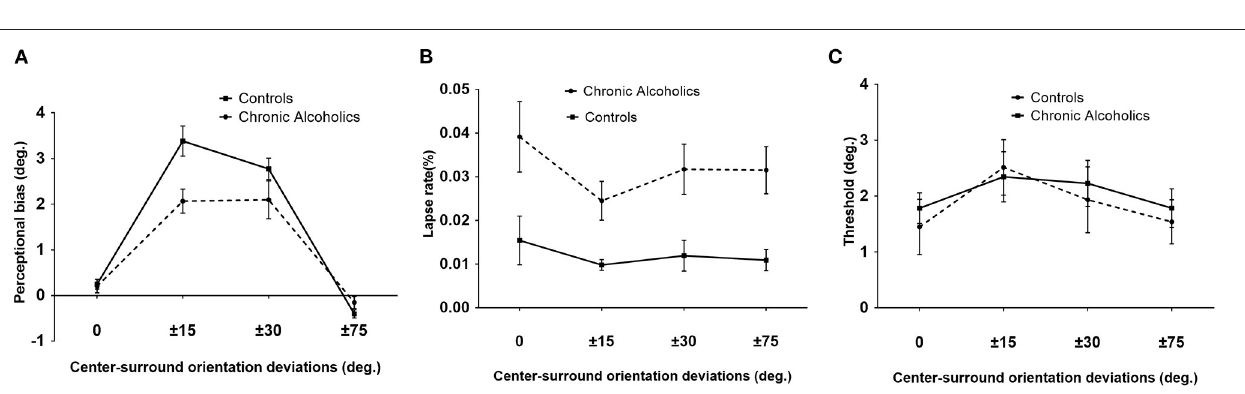
FIGURE 2 | Tilt illusion (TI) results. (A) TI effects, indicated by perceptual orientation bias necessary to perceive the center as vertical, as a function of various angles between surround inducer and center target for patients with chronic alcoholism (broken line) and healthy controls. Perceptual biases of ± 15 ◦ and ± 30 ◦ are tilt repulsion effects, while those under ± 75 ◦ were attraction effects. (B) Lapse rate values for chronic alcoholics (broken line) and controls. (C) Orientation thresholds around perceived verticality for chronic alcoholics (broken line) and controls (blue). Error bars are